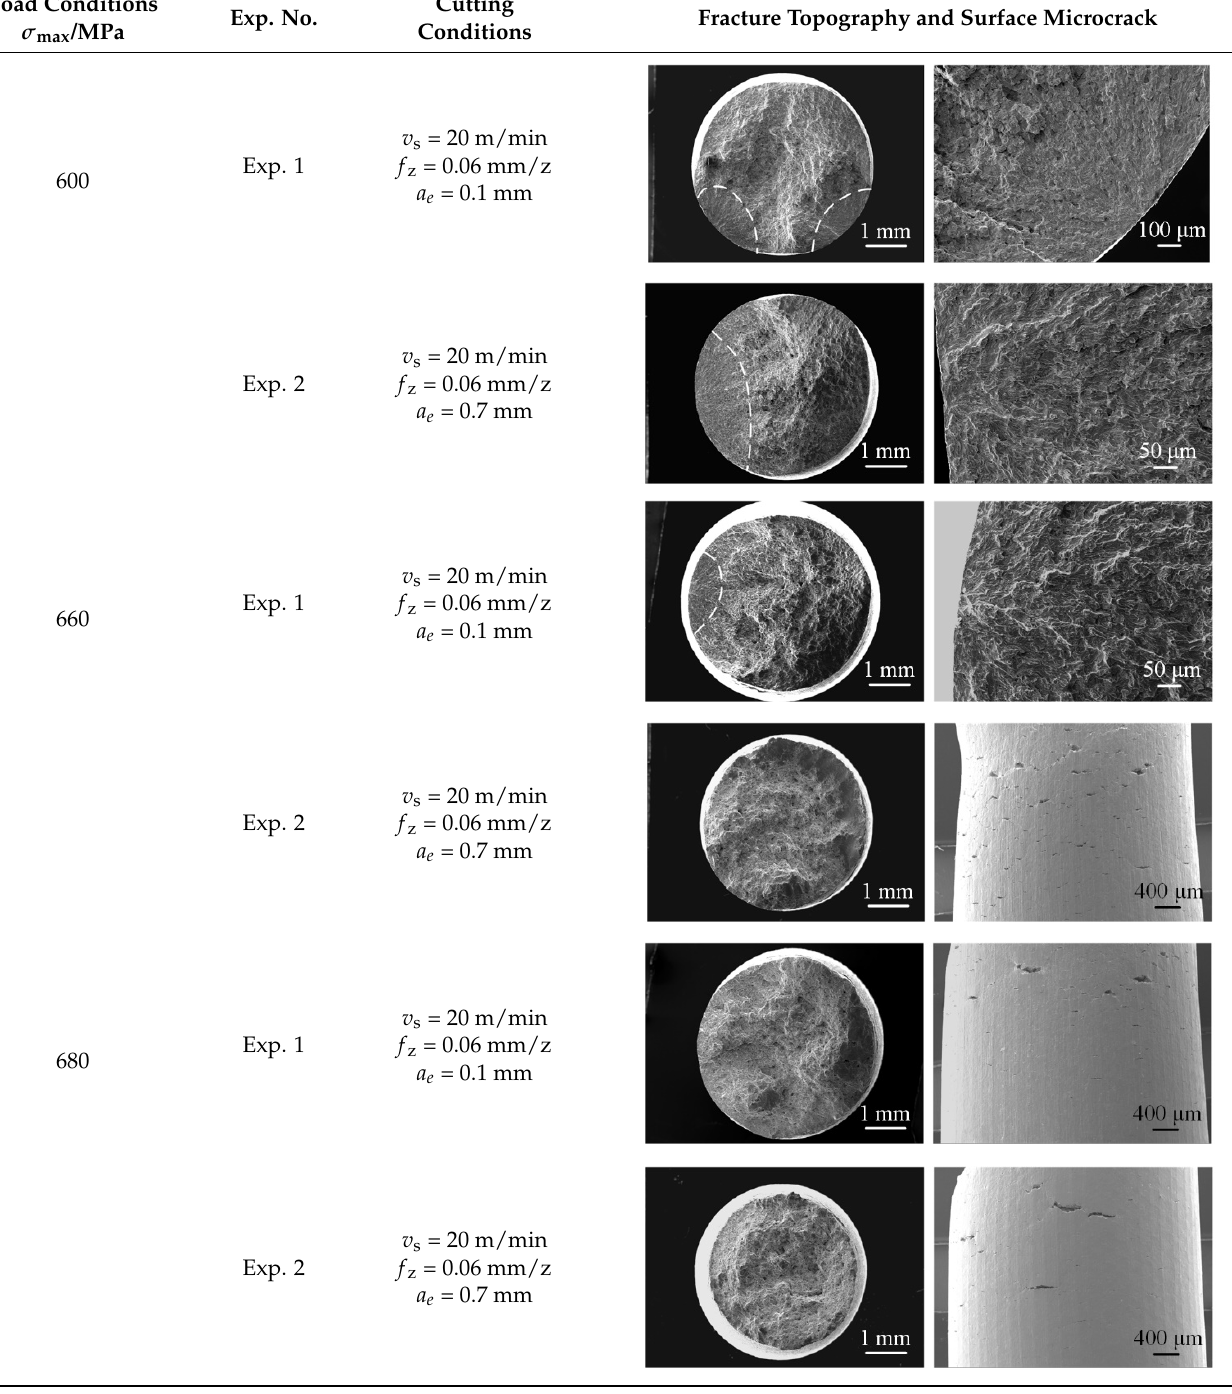
Figure 5. Fatigue life of TC17 specimens under different load conditions.